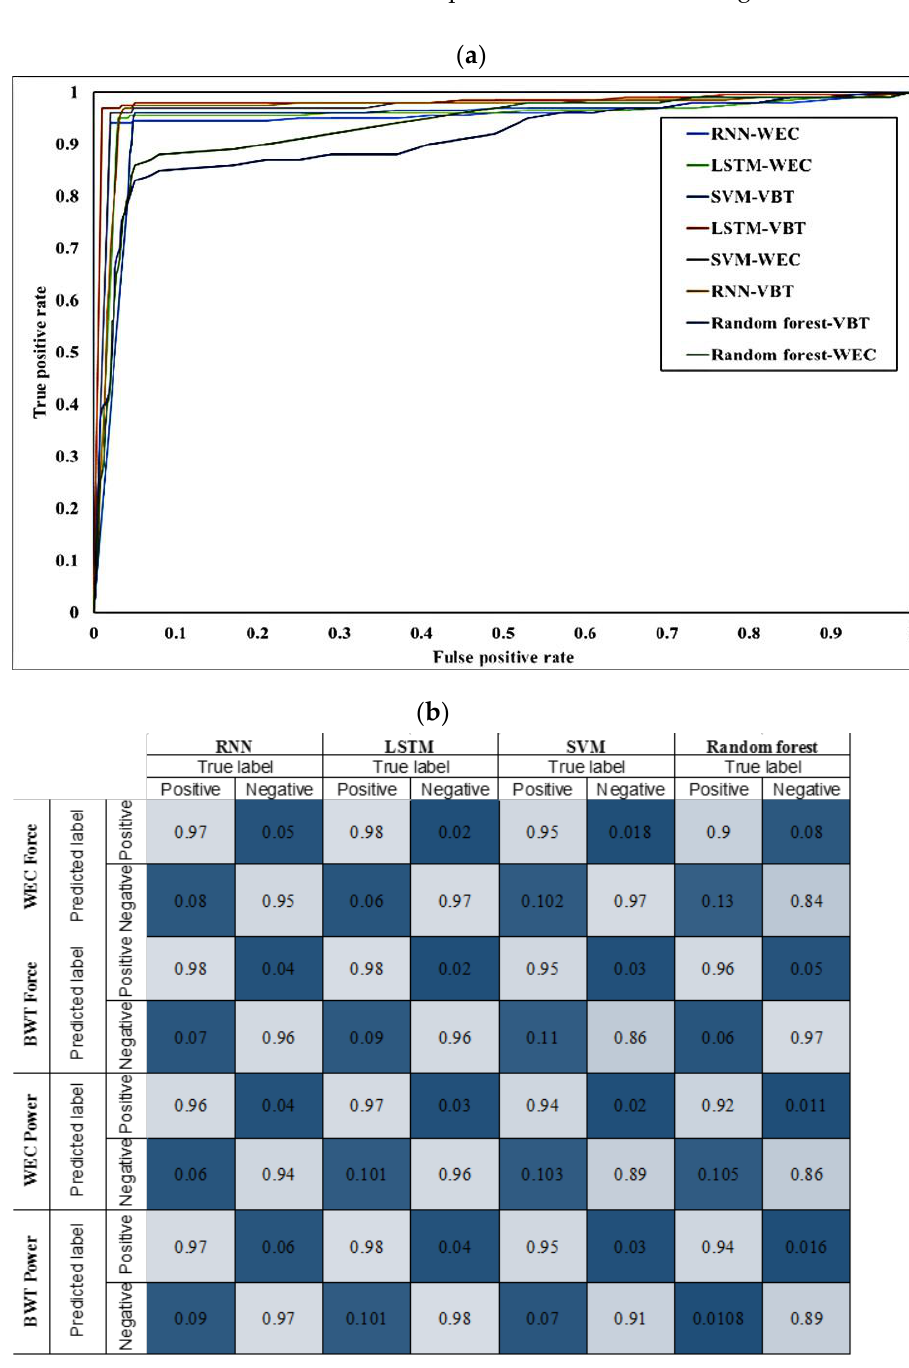
and WEC values. and WEC